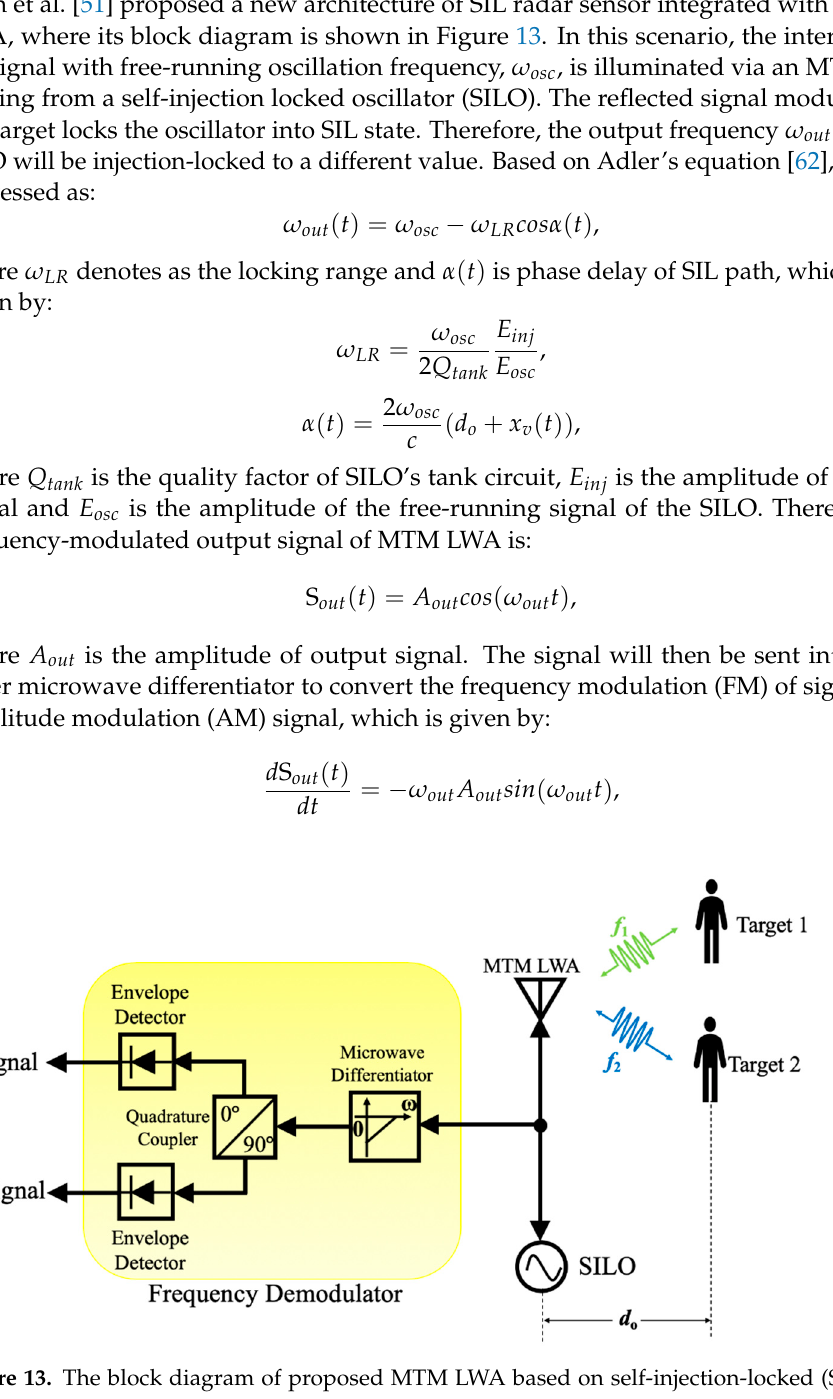
Figure 14. Layout and prototype of 1-D MTM LWA at 2.4 GHz. ( a ) ( b ) Figure 15. ( a ) Radiation pattern of 1-D MTM LWA at 2.4 GHz; ( b ) its S-parameters [51]. Figure 16 presents the prototype of the radar sensor module. The operation frequency of MTM LWA can be tuned from 2.04 GHz to 2.48 GHz through a tunable oscillator, which